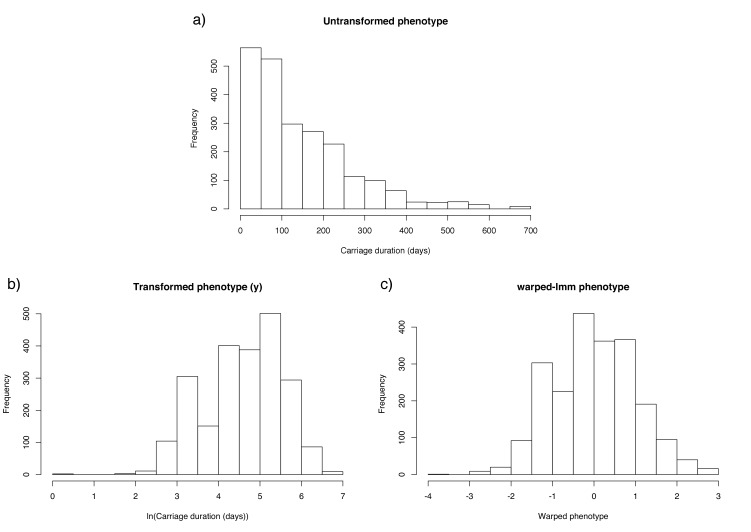
Distribution of carriage duration, and effect of monotonic transformation.Panel (a) shows a histogram of the inferred carriage duration, (b) shows this result after the natural logarithm is taken, and (c) after the warping function is applied.10.7554/eLife.26255.010Figure 3—source data 1.Sequenced isolates and their untransformed inferred carriage durations.10.7554/eLife.26255.011Figure 3—source data 2.Sequenced isolates and their warped carriage durations.